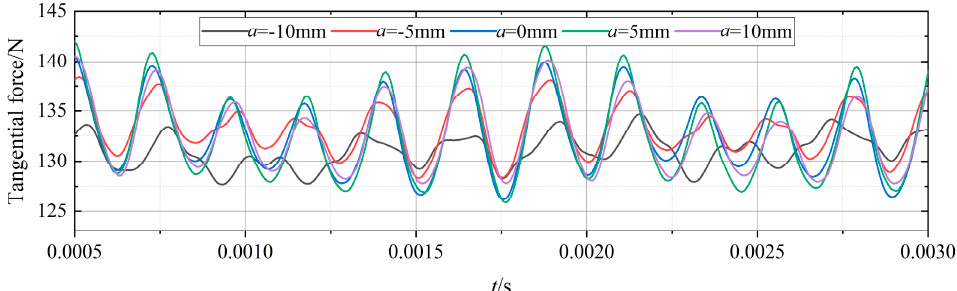
Figure 8. Tangential force–time domain distribution under design conditions.